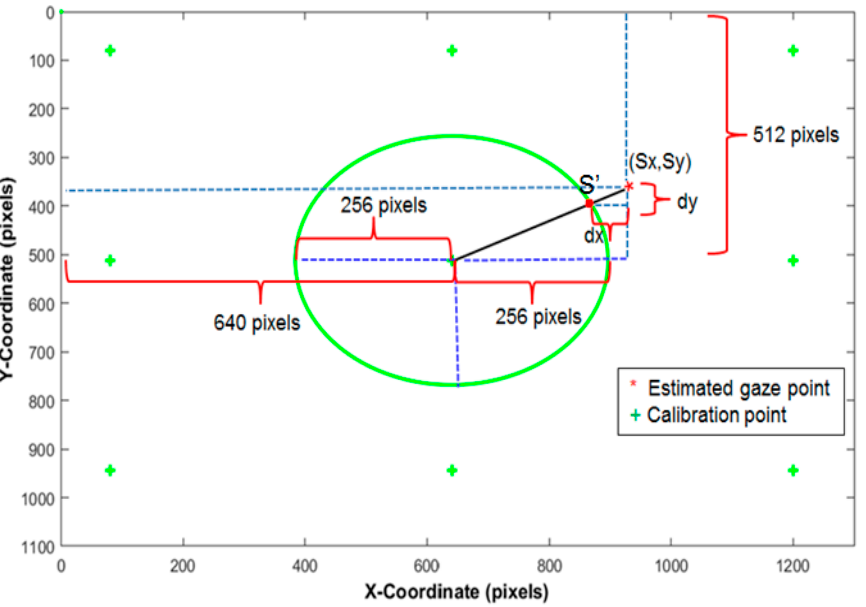
Figure 12. Gaze point estimation geometry on the user screen.